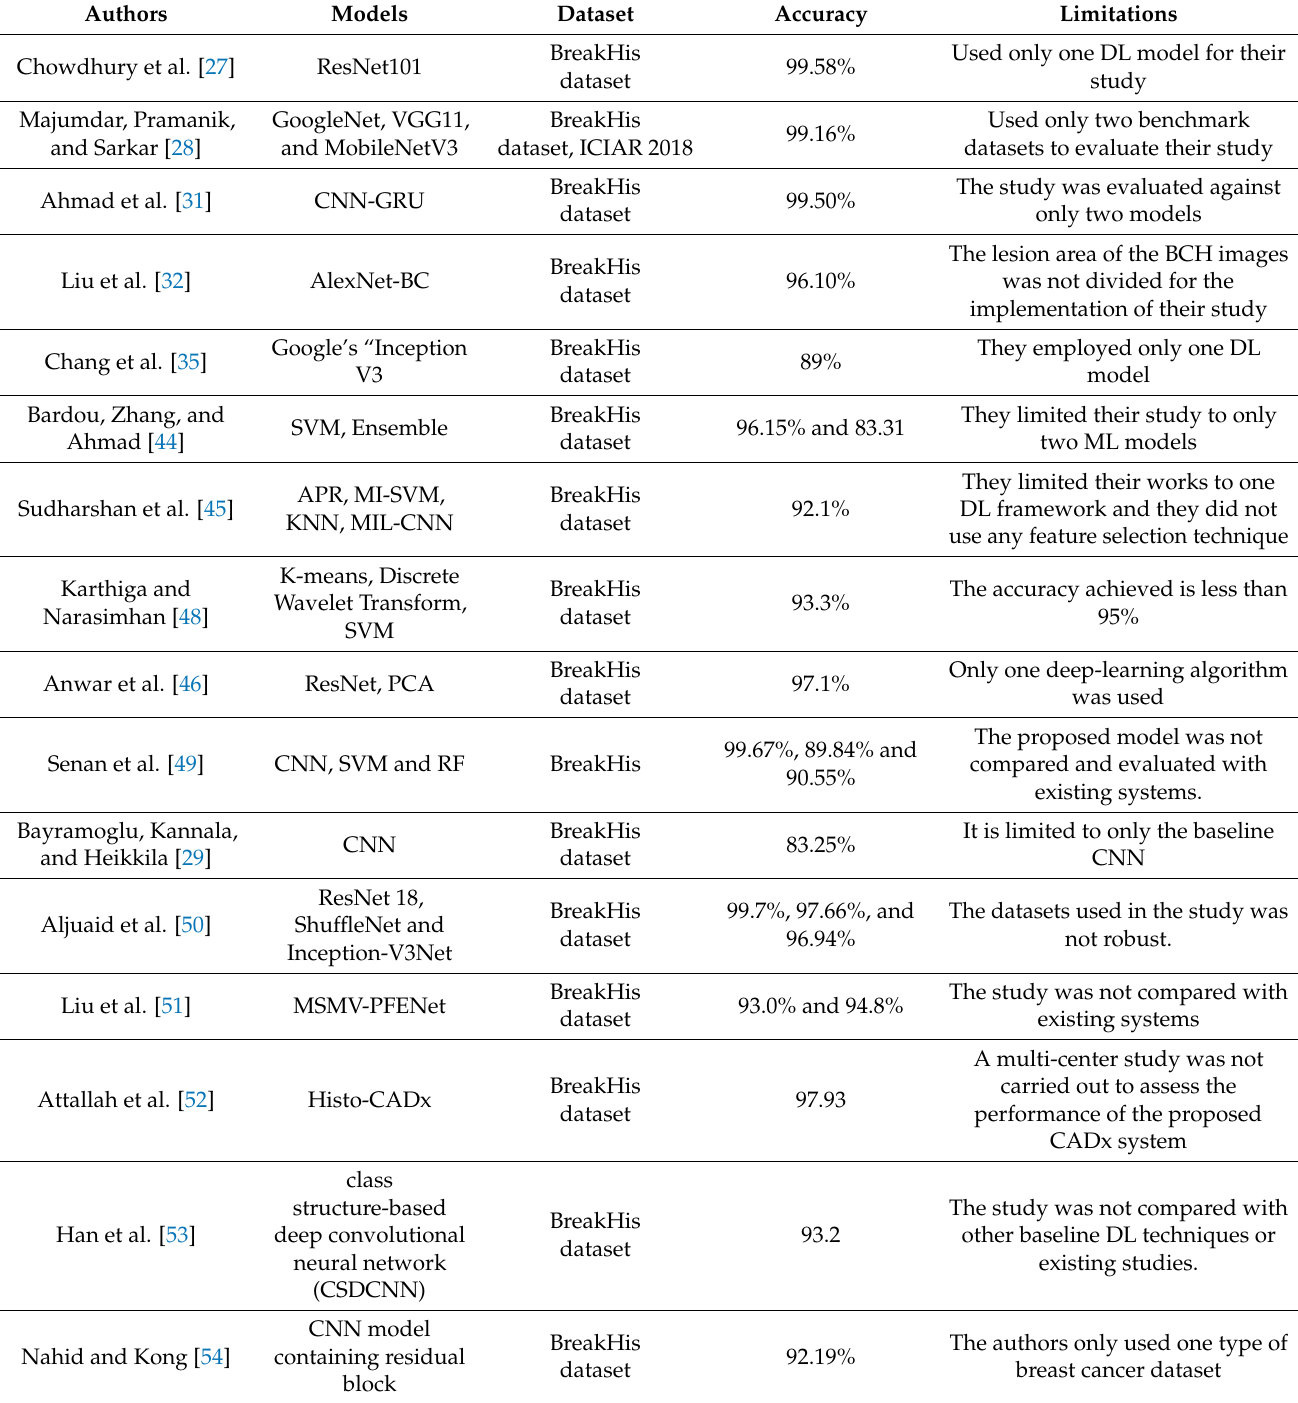
Table 1. Summary of related